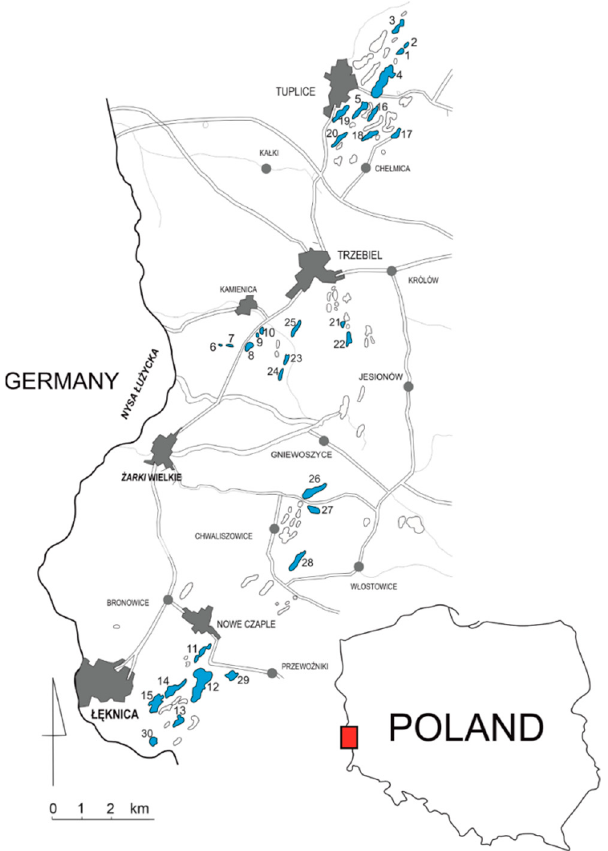
Figure 1. The locations of the investigated lakes (marked in black and numbered), originally pub- lished in Pukacz et al. 2018